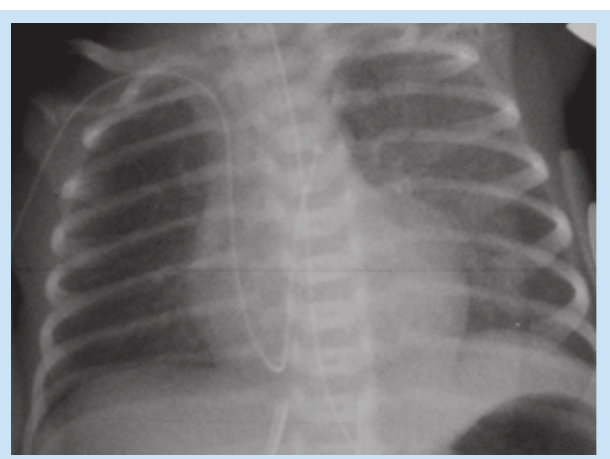
Fig. 6. Complications of lines and tubes. Right-sided central catheter has its tip too far - beyond the right atrium. The nasogastric tube and umbilical vein catheter tips are well positioned.